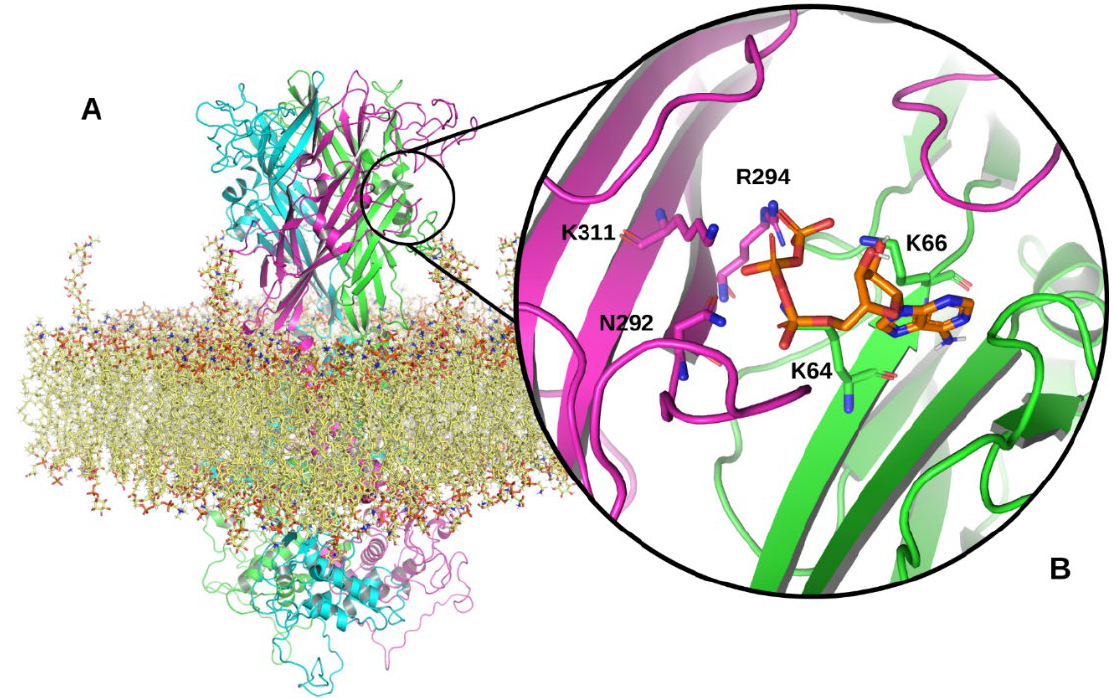
Figure 1. Model of the full-length human P2X7R. ( A ) Structure of the trimeric P2X7R within an epithelial membrane model. The three P2X7 subunits are shown in magenta, cyan and green ribbon representations. The epithelial membrane is shown in yellow. ( B ) A zoomed in view of a P2X7R ATP-binding site located between two P2X7 subunits in the extracellular domain of the receptor. ATP is shown in orange interacting with N292, R294, and K311 on one subunit and K64 and 66 on the adjacent P2X7 subunit. Structural model produced using PyMOL software version 2.5.2, Schrödinger, Inc., New York, NY, USA [23]. Each P2X7 subunit that forms the trimeric P2X7R is a product of the human P2RX7 gene, located on chromosome 12 [24]. The full-length P2X7A subunit, comprised of 595 amino acids, is translated from a 13 exon mRNA transcript [24]. P2X7A has an